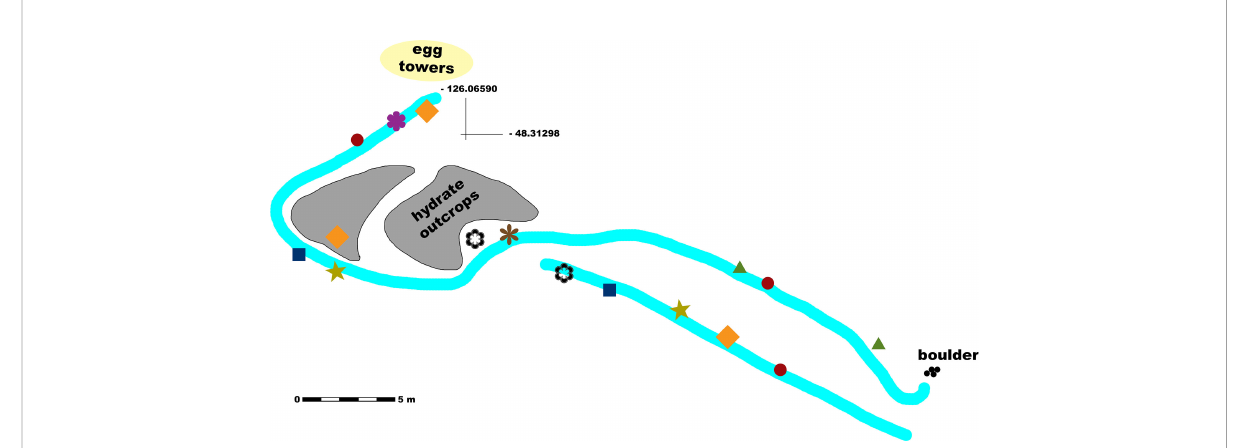
FIGURE 1 Schematic map of the study site (Barkley Canyon hydrates, 870 m depth) with marked locations of several observations. The main transect lines are represented in light cyan. Observations of jelly fi sh carcasses; decaying macroalgae; sable fi sh positioning themselves facing against the current; Opisthoteuthidae octopus encounters; aggregations of small crabs; adult crabs with severed limbs; recorded crab aggression; and crab mating behavior are represented by dark red circles; olive-colored stars; green triangles; dark blue squares; orange diamonds; purple, thick fl ower symbols; brown, thin fl ower symbols; and black empty fl ower symbols,